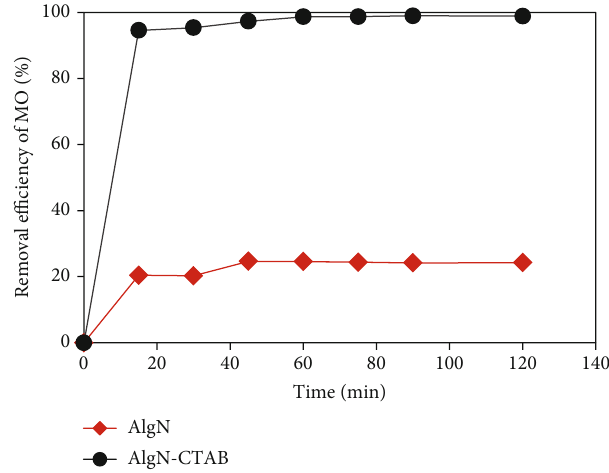
of the AlgN and AlgN-CTAB. pzc